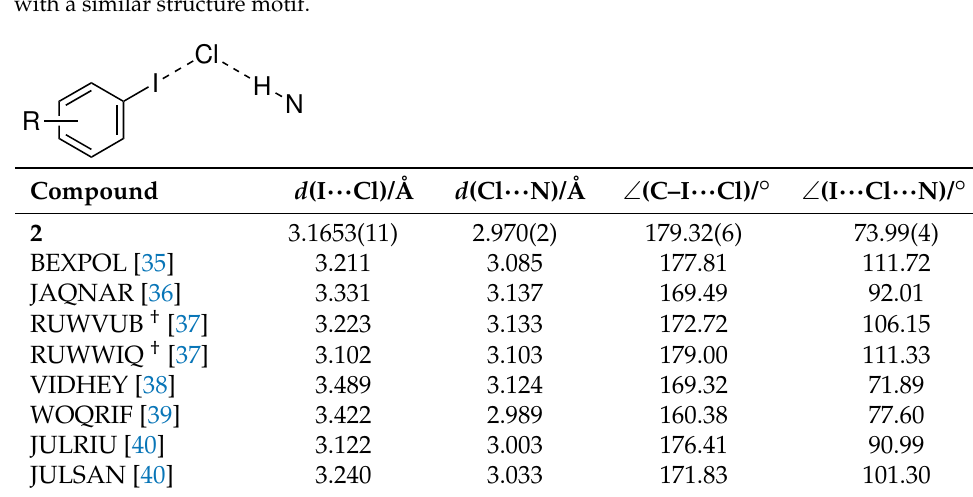
Table 1. Comparison between important distances and angles in 2 and literature known compounds with a similar structure motif.